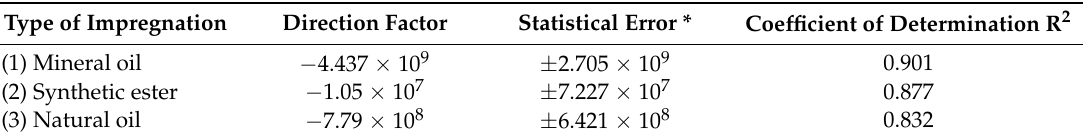
Table 1. Slopes of linear approximation functions from Figure 9 and coefficient of determination R 2 . Type of Impregnation